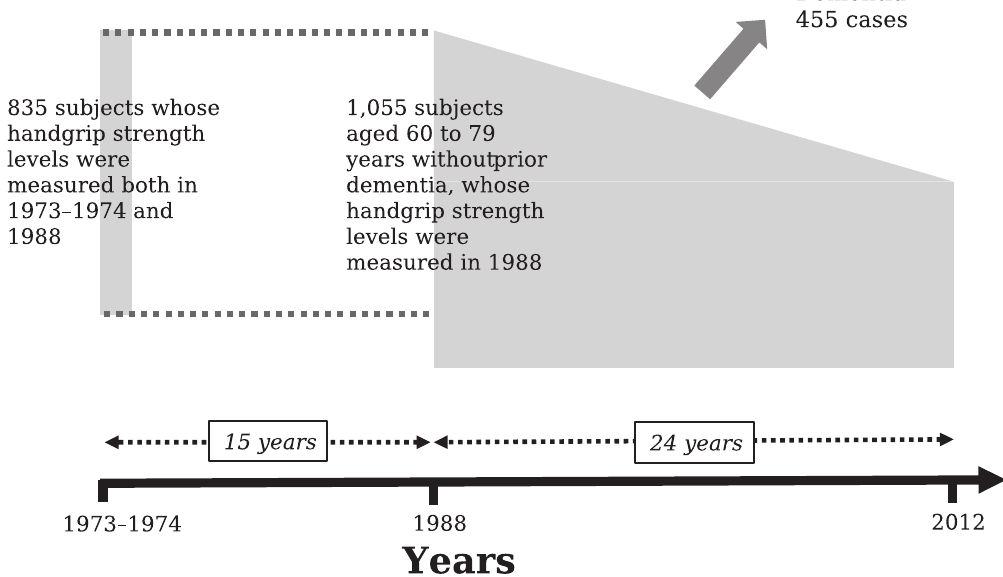
Figure 1. Diagram of the study